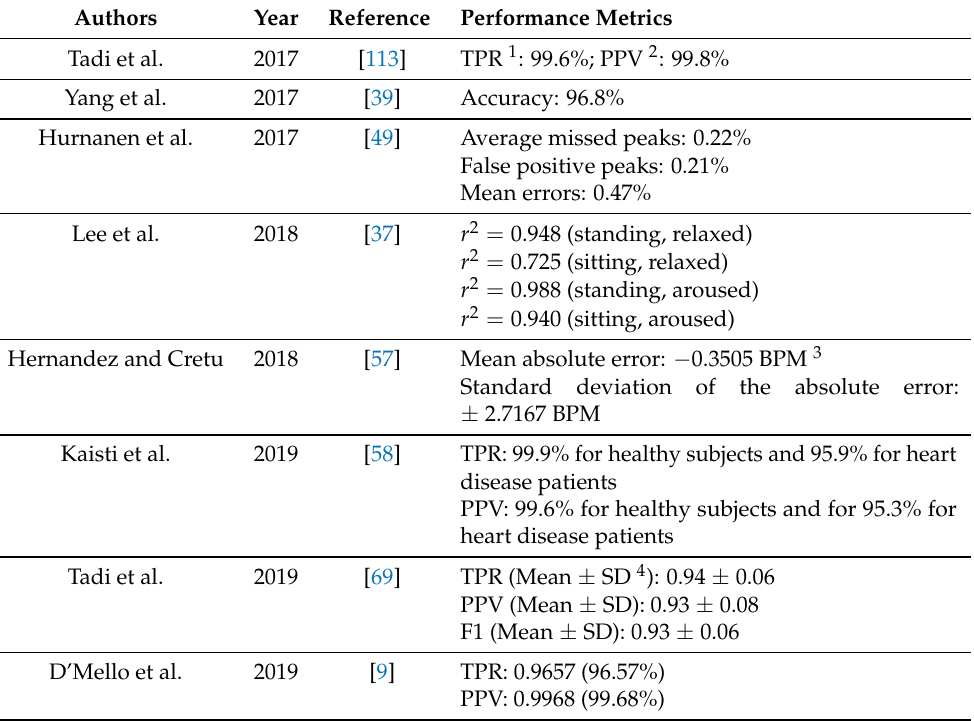
Table 2. The comparison of the performance of heart beat detection in GCG